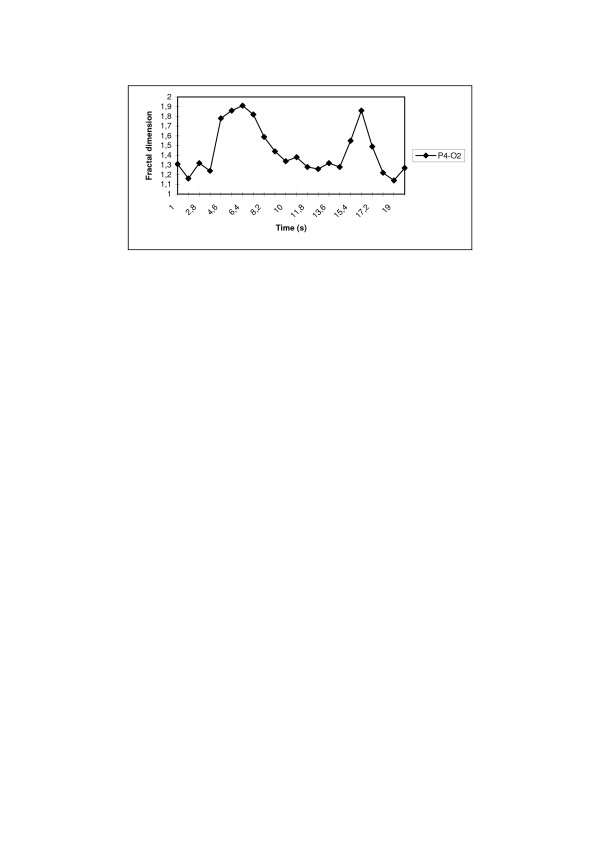
Fractal dimension of 19 seconds EEG-epoch (P4-O2) with eyes-opening (in 4. s.) and eyes-closing (in 15. s.).